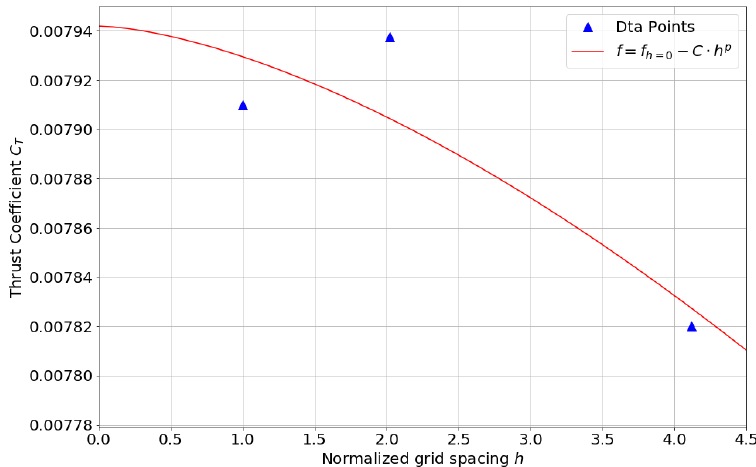
Figure A1. Grid convergence study with coarse, medium, and fine grids.